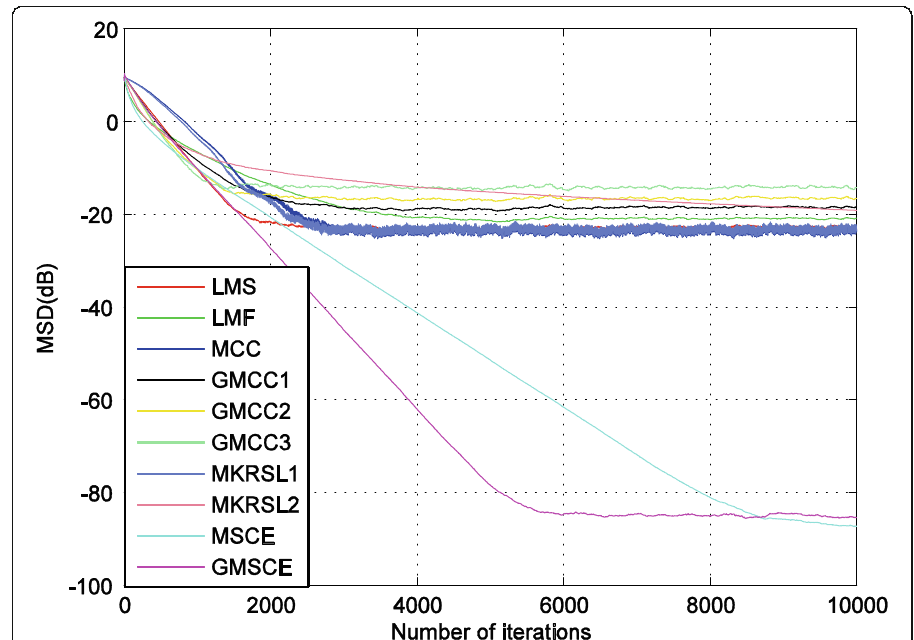
Fig. 5 Comparisons of the algorithms under super-Gaussian noise shown in Fig. 2a